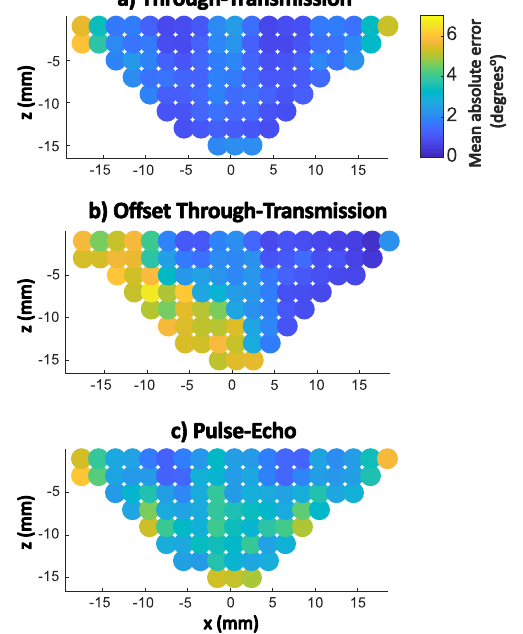
Figure 7. Mean absolute error (MAE) for each weld sub-region of the predicted grain orientations (to- mographic reconstructions) averaged over 100 test models for ( a ) the through-transmission, ( b ) offset through-transmission, and ( c ) pulse-echo transducer array configurations.